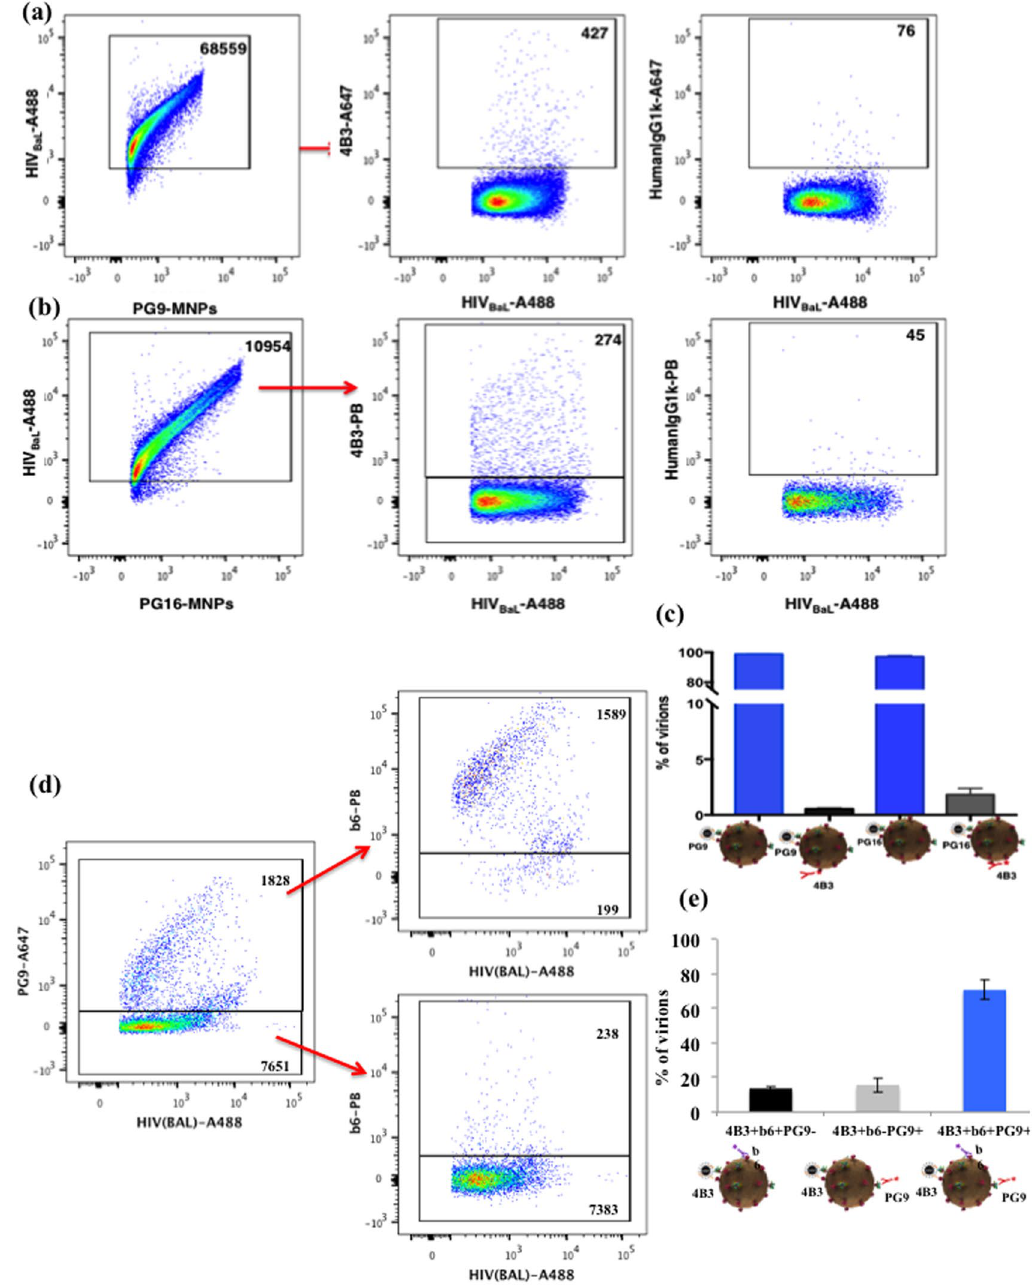
Figure 7. Flow virometry of fluorescence-labeled HIV-1 BaL virions. ( a ) Alexa Fluor 488 -labeled virions were captured with PG9-MNPs (left panel) and stained with AlexaFluor 647 4B3 antibodies for the presence of stumps/uncleaved Envs (center panel) or with AlexaFluor 647-labeled isotype control antibodies (right panel). Indicated are the numbers of events. A representative experiment out of three is shown. ( b ) Alexa Fluor 488 -labeled virions were captured with PG16-MNPs (left panel) and stained with Pacific Blue-labeled 4B3 antibodies for the presence of stumps (center panel) or with Pacific Blue-labeled isotype control antibodies (right panel). Indicated are the numbers of events. A representative experiment out of three is shown. ( c ) Fractions of PG9-MNPs and PG16-MNPs captured Alexa Fluor 488 virions positive for 4B3. Each bar represents mean ± SEM of three experiments. ( d ) Alexa Fluor 488 -labeled virions were captured with 4B3- MNPs and stained with two antibodies: AlexaFluor 647-labeled PG9 and Pacific Blue-labeled b6. Left panel: Virions were captured with 4B3-MNPs and stained with PG9. Upper right panel: 4B3-MNP-captured virions positive for PG9 and stained with b6. Lower right panel: 4B3-MNP-captured virions negative for PG9 and stained with b6. Indicated are the numbers of events. A representative experiment out of three is shown. ( e ) Distribution of 4B3-MNPs–captured Alexa Fluor 488 labeled virions stained with two antibodies: AlexaFluor 647-labeled PG9 and Pacific Blue-labeled 4B3. Each bar represents mean ± SEM of three